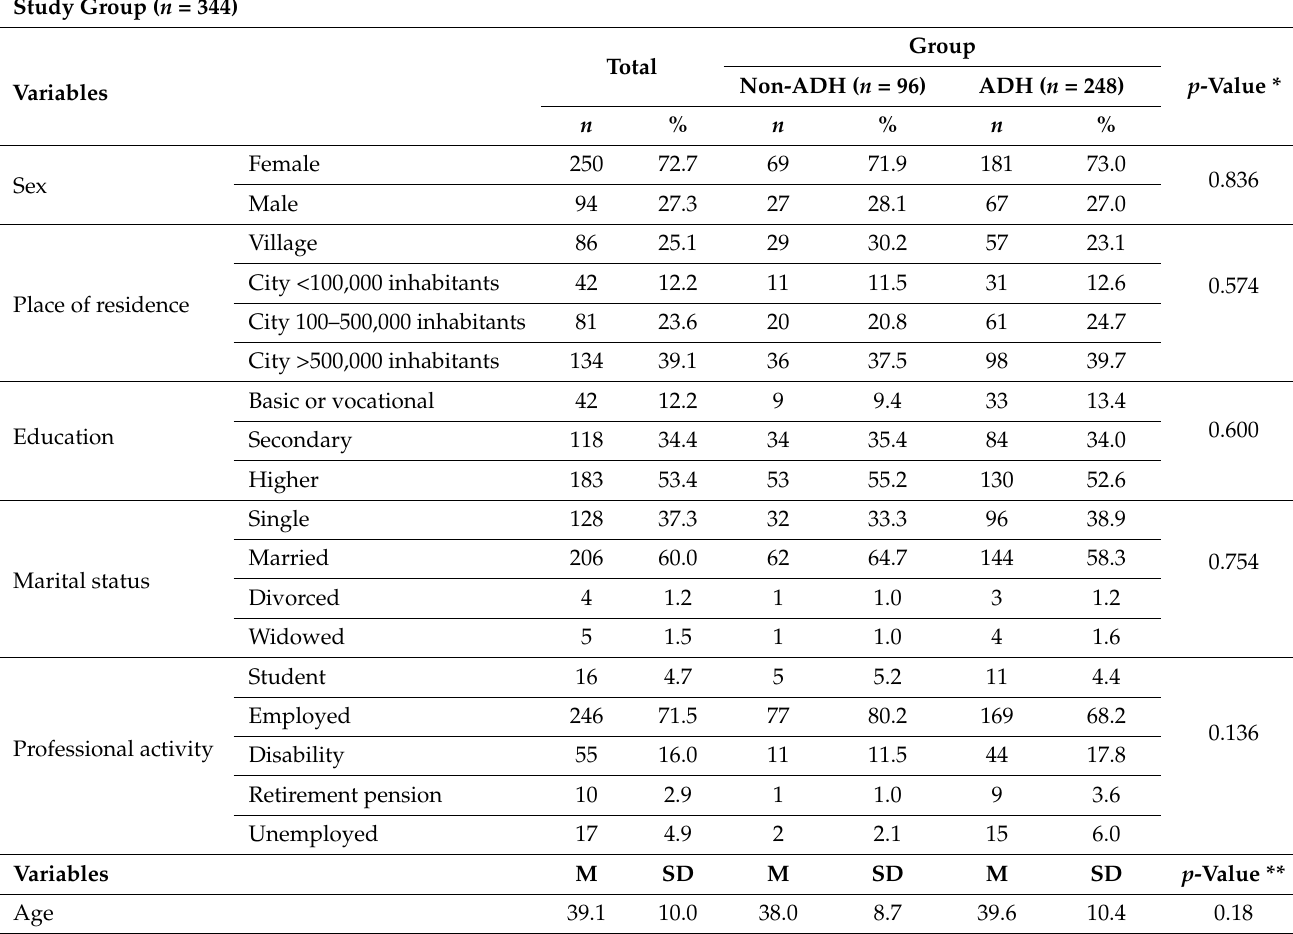
Table 1. Characteristics of the study group with a comparison between adherence and non-adherence